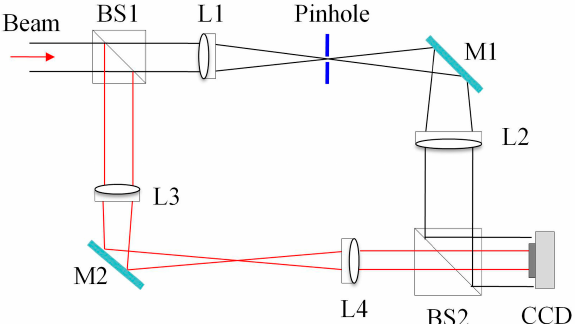
Figure 1. Experimental setup of SRI-WFS: BS1, BS2, beam-splitters, L1–L4, lens with the focal length f 1 = f 4 = 100 mm and f 2 = f 3 = 300 mm, respectively; pinhole, spatial filtering plate with diameter d pin = 25 µ m; M1, M2, reflection mirrors.